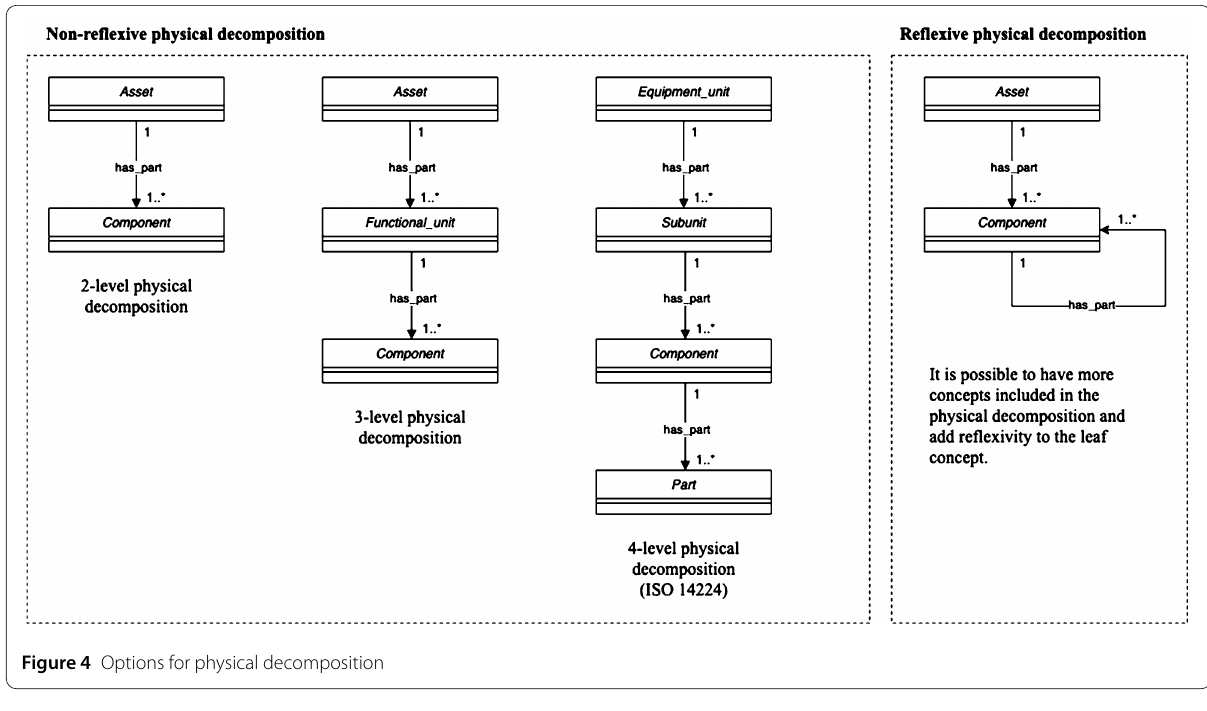
Figure 4 Options for physical decomposition